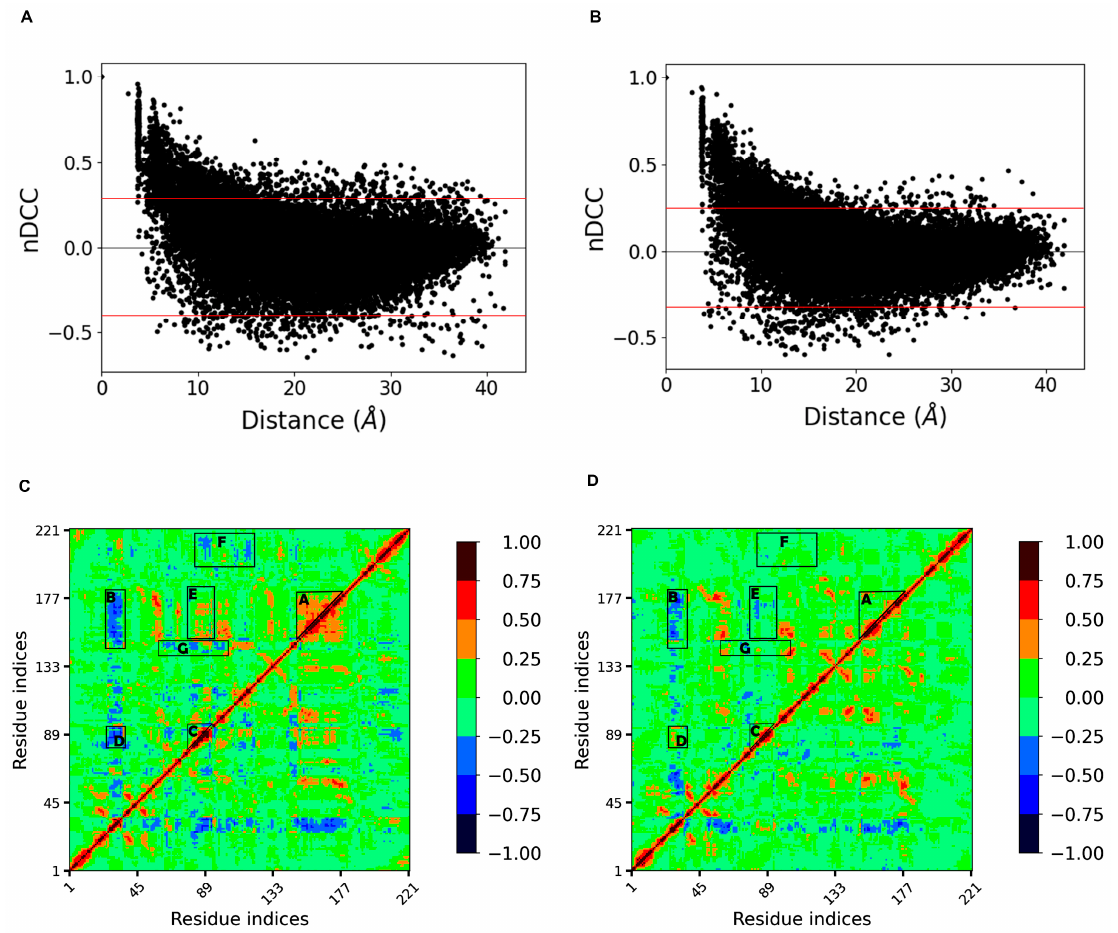
Figure 7. ( A , B ) show the distributions of the correlation indices with increasing distance between residues at 300 K and 350 K, respectively; the distance between two red lines shows the thickness of the boat-shaped distribution, and the distance narrowed at 350 K, indicating a decreasing trend of both positive and negative correlations (closer to 0); ( C , D ) show the cross correlation matrix diagrams at 300 K and 350 K, respectively.